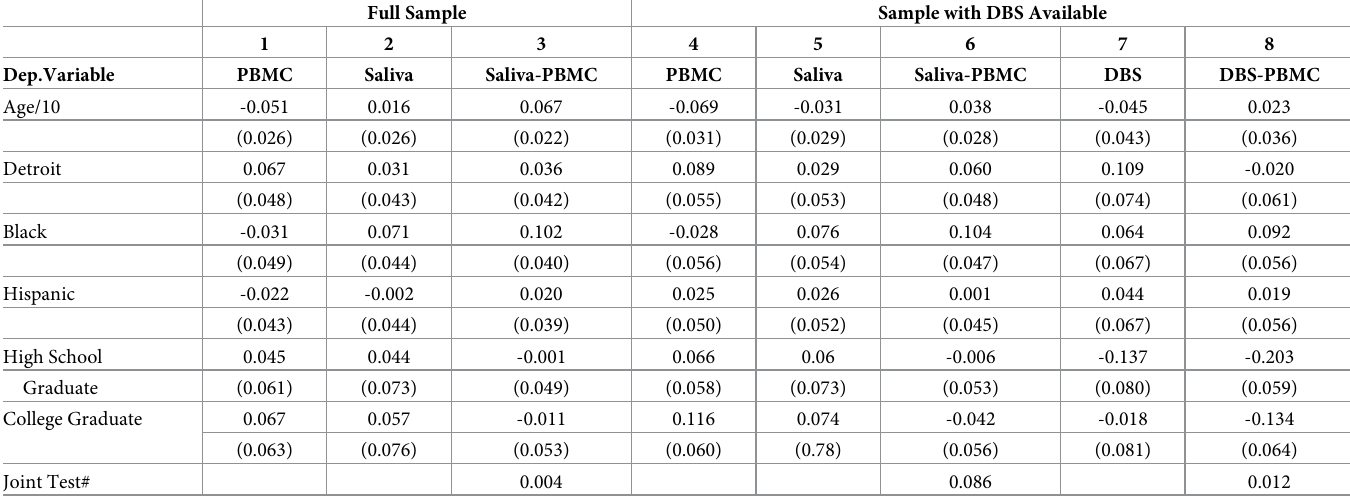
Table 5. The estimated effect of age, location, race, and education on ln(TL) by specimen